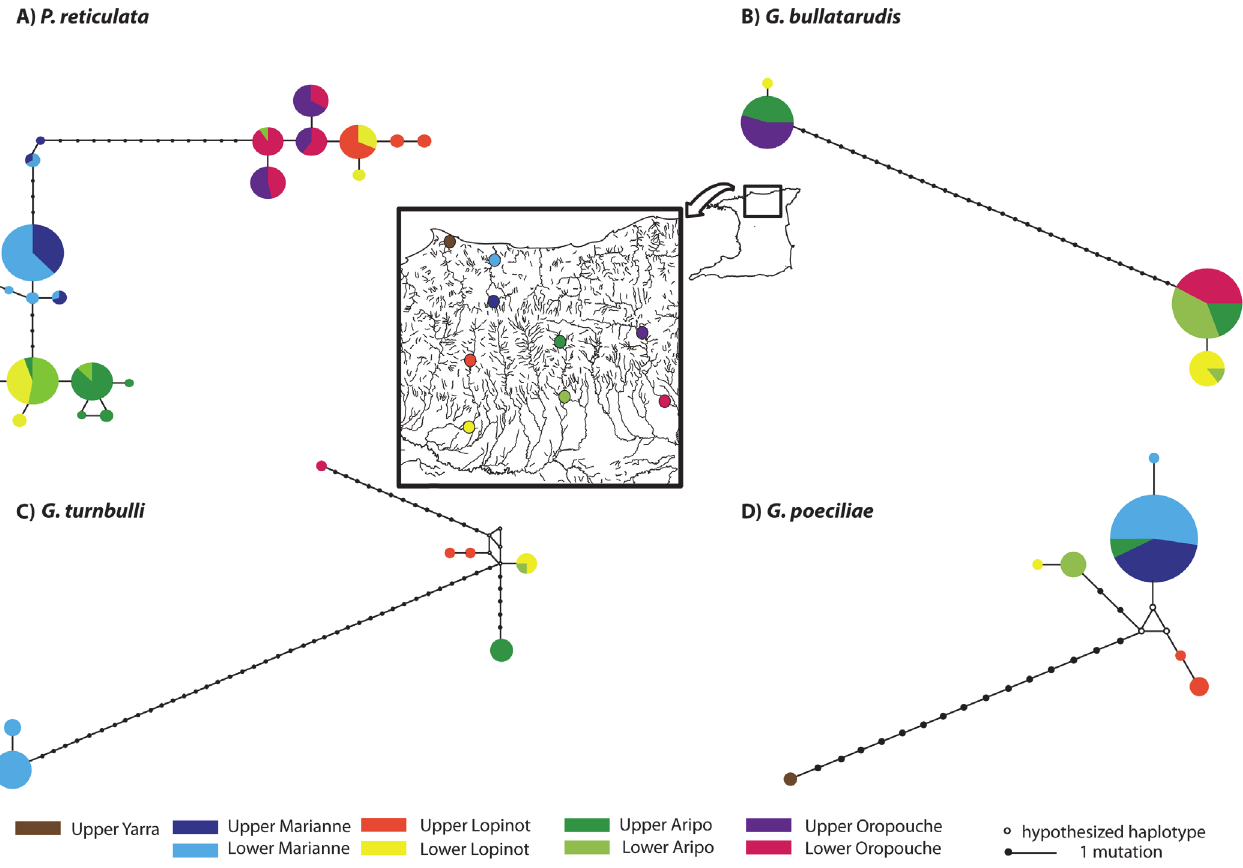
Figure 1. Median joining haplotype networks estimated for (A) Poecilia reticulata , and (B-D) for each Gyrodactylus species from nine localities in the Northern Mountain Range of